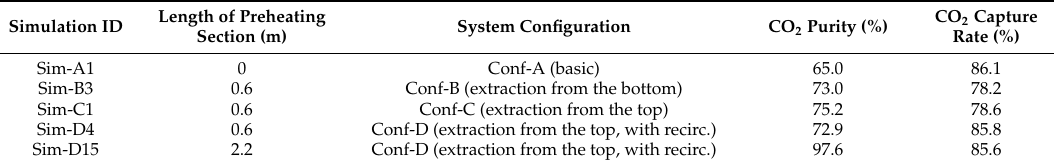
Table 8. Summary of results from different MBTSA process